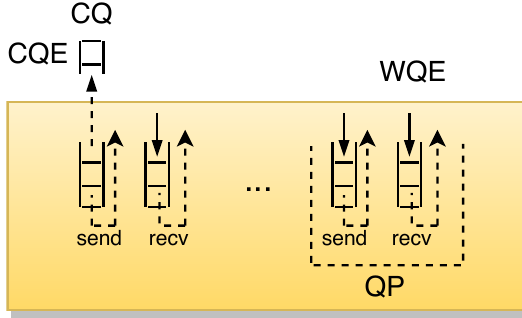
Figure 1. InfiniBand Architecture.